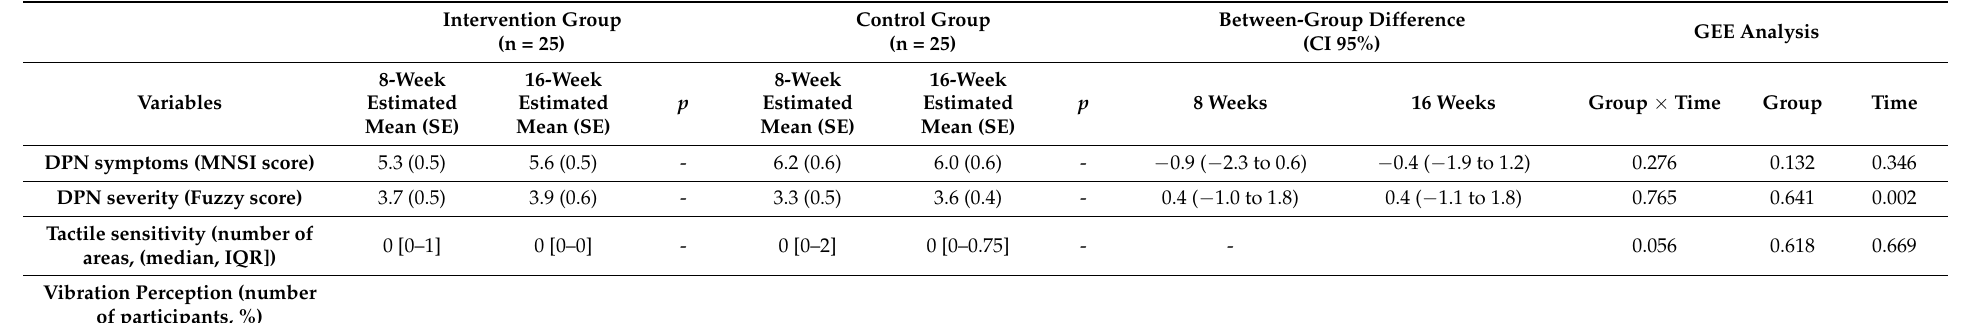
Table 2. Estimated mean (standard error, SE), p -values of the interaction, group and time effects, and between-group mean difference at 8 and 16 weeks (95% confidence interval) of the clinical outcomes for each group (control and intervention) at two follow-up assessments (8 and 16 weeks). Intervention Group Control Group Between-Group Difference GEE (n = 25) (n = 25) (CI 95%)